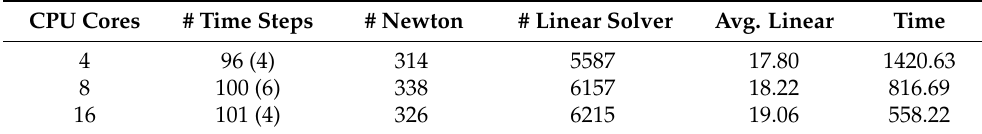
Table 10. Numerical summaries of Example